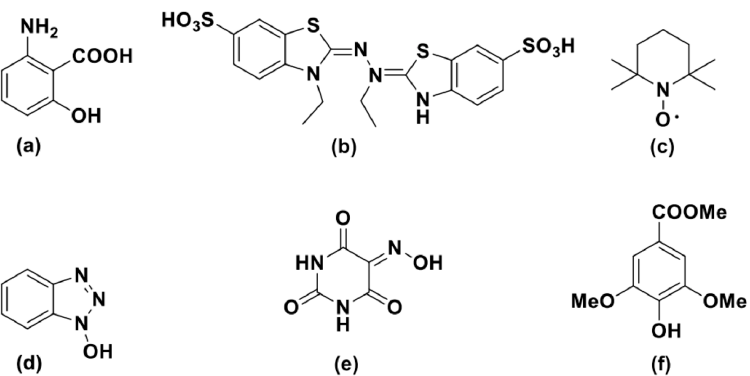
Figure 1. Examples of chemical mediators employed in laccase-mediator system (LMS). ( a ) 3-Hy- droxyanthranilic acid (HAA); ( b ) 2,20-azino-bis-(3-ethylbenzothiazoline-6-sulphonic acid) (ABTS); ( c ) 2,2,6,6-tetramethyl piperidine-1-yloxy (TEMPO); ( d ) N -hydroxybenzo-triazole (HBT); ( e ) vio- luric acid (VLA); ( f ) methyl ester of 4-hydroxy-3,5-dimethoxy-benzoic acid (syringic acid). The exploitation of TEMPO or ABTS and laccases for the oxidation of primary alco- hols and even benzylic secondary alcohols was reported years ago [57,58]. Later on, the laccase from T. pubescens , together with TEMPO, was used to catalyze the regioselective oxidation of the primary hydroxyl groups in a panel of sugar derivatives to the corre- sponding carboxylic acids via the intermediate aldehydes (Scheme 3a). The efficiency of this system was initially tested with mono- and disaccharides (i.e., phenyl β - D -glucopy- ranoside), and then this LMS approach was also exploited to achieve the partial oxidation of a water soluble cellulose sample [59]. The same approach was exploited for the efficient and mild oxidation of more complex bioactive glycosides, e.g., thiocolchicoside (Scheme 3b) [48]. Scheme 3. Exploitation of laccase-mediator systems for the regioselective oxidation of primary hydroxyl groups. ( a ) Oxi- dation of glucosides to the corresponding glucuronic acids; ( b ) oxidation of the bioactive glucoside thiocolchicoside [48]. The oxidation of natural polysaccharides by TEMPO (regenerated in situ by different oxidants) is an old reaction and has been recently reviewed [60]. In comparison to other approaches, the use of laccases for the reoxidation of TEMPO proved to be very mild and, promoting a lower degree of oxidations, resulted in the formation of soft gels. The prop-